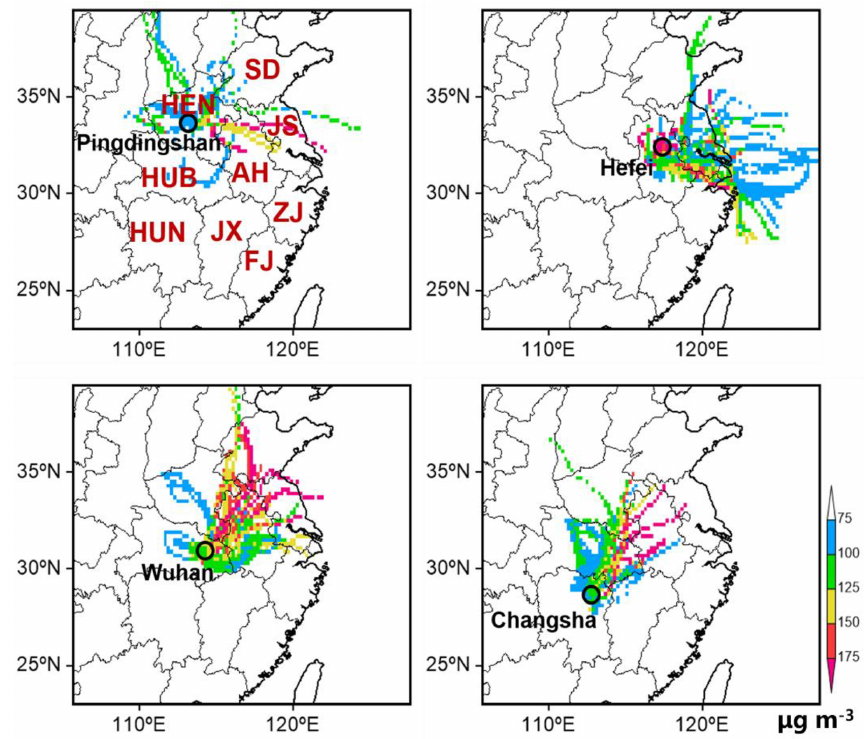
Figure 12. CWT maps during EP2 at four representative cities (Pingdingshan, Hefei, Wuhan, and Changsha) that represent Henan, An- hui, Hubei, and Hunan, respectively. The maps were created by NCAR Command Language (NCL) (http://www.ncl.ucar.edu/, last access: 22 December